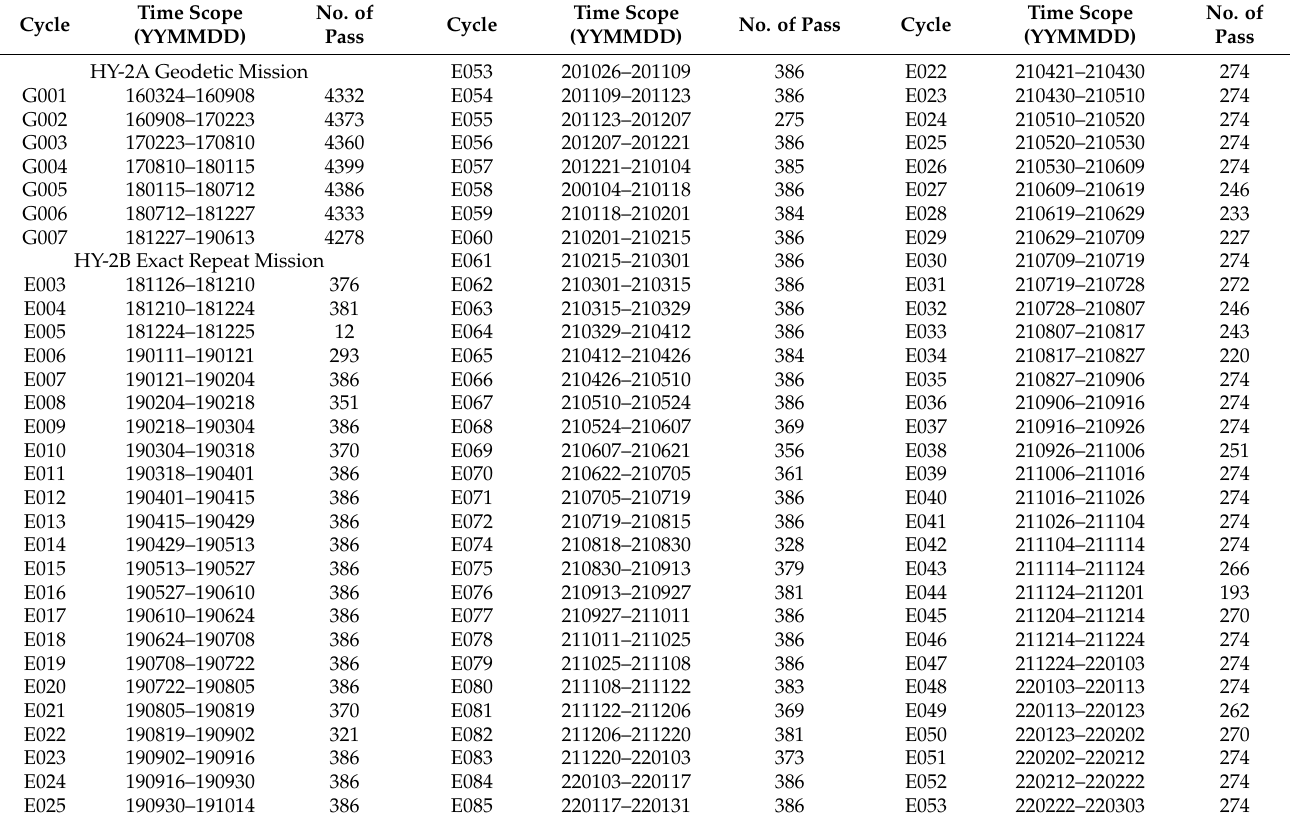
Table A1. The general information for each cycle of acquired HY-2 altimeter